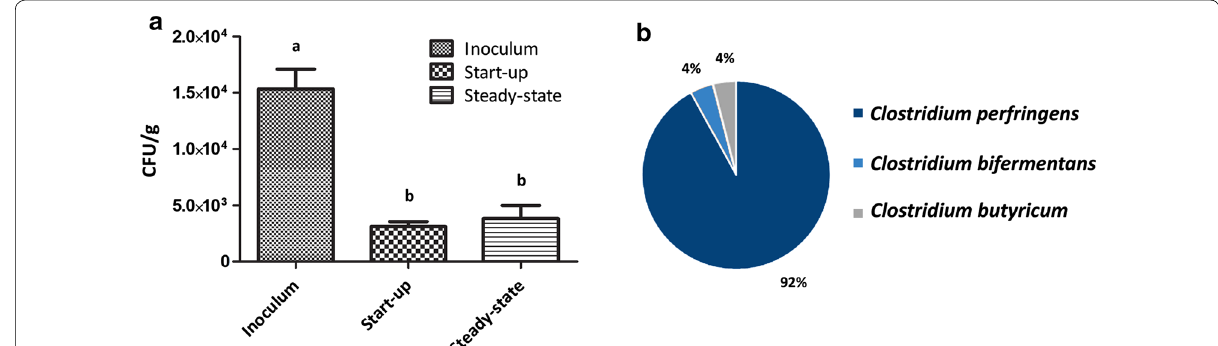
Fig. 5 Cultivable Clostridium spores. a Spore counts in the inoculum and in the reactor digestate at start-up and in steady-state conditions. Letters in the graph indicate significant differences between samples, based on Tukey’s test. b Identification and relative abundance of the isolated Clostridium